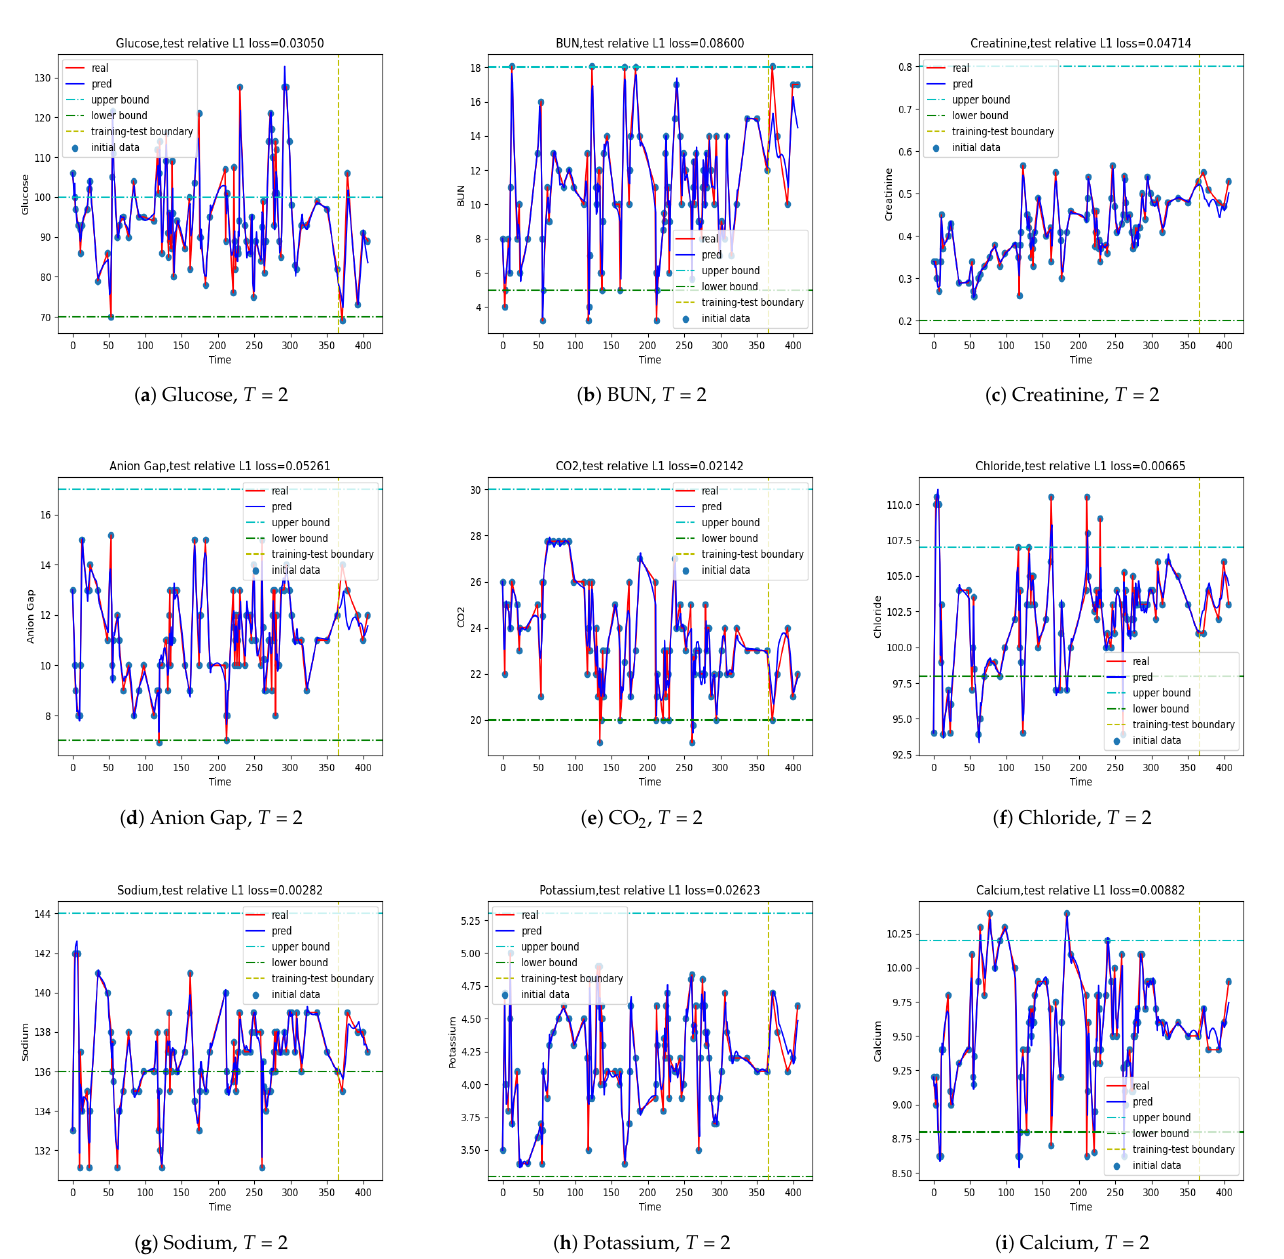
Figure A2. The one-step prediction of the LSTM model for patient PH with time step T =